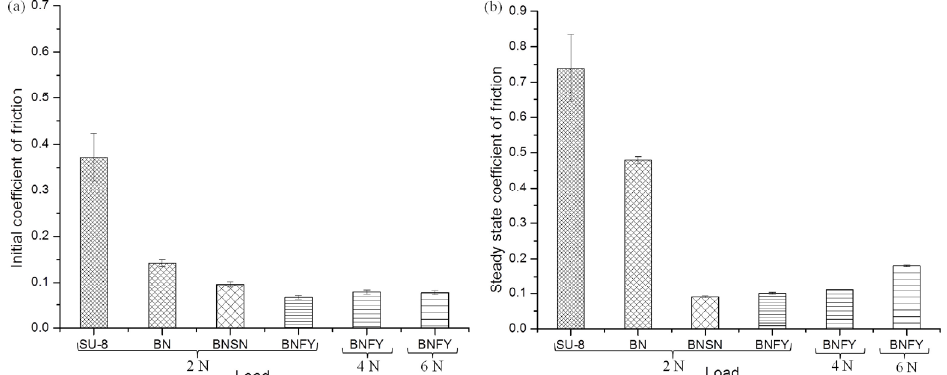
Fig. 8 Raw friction data of the BNFY composite coating at a 4 N normal load and 0.28 m/s sliding speed